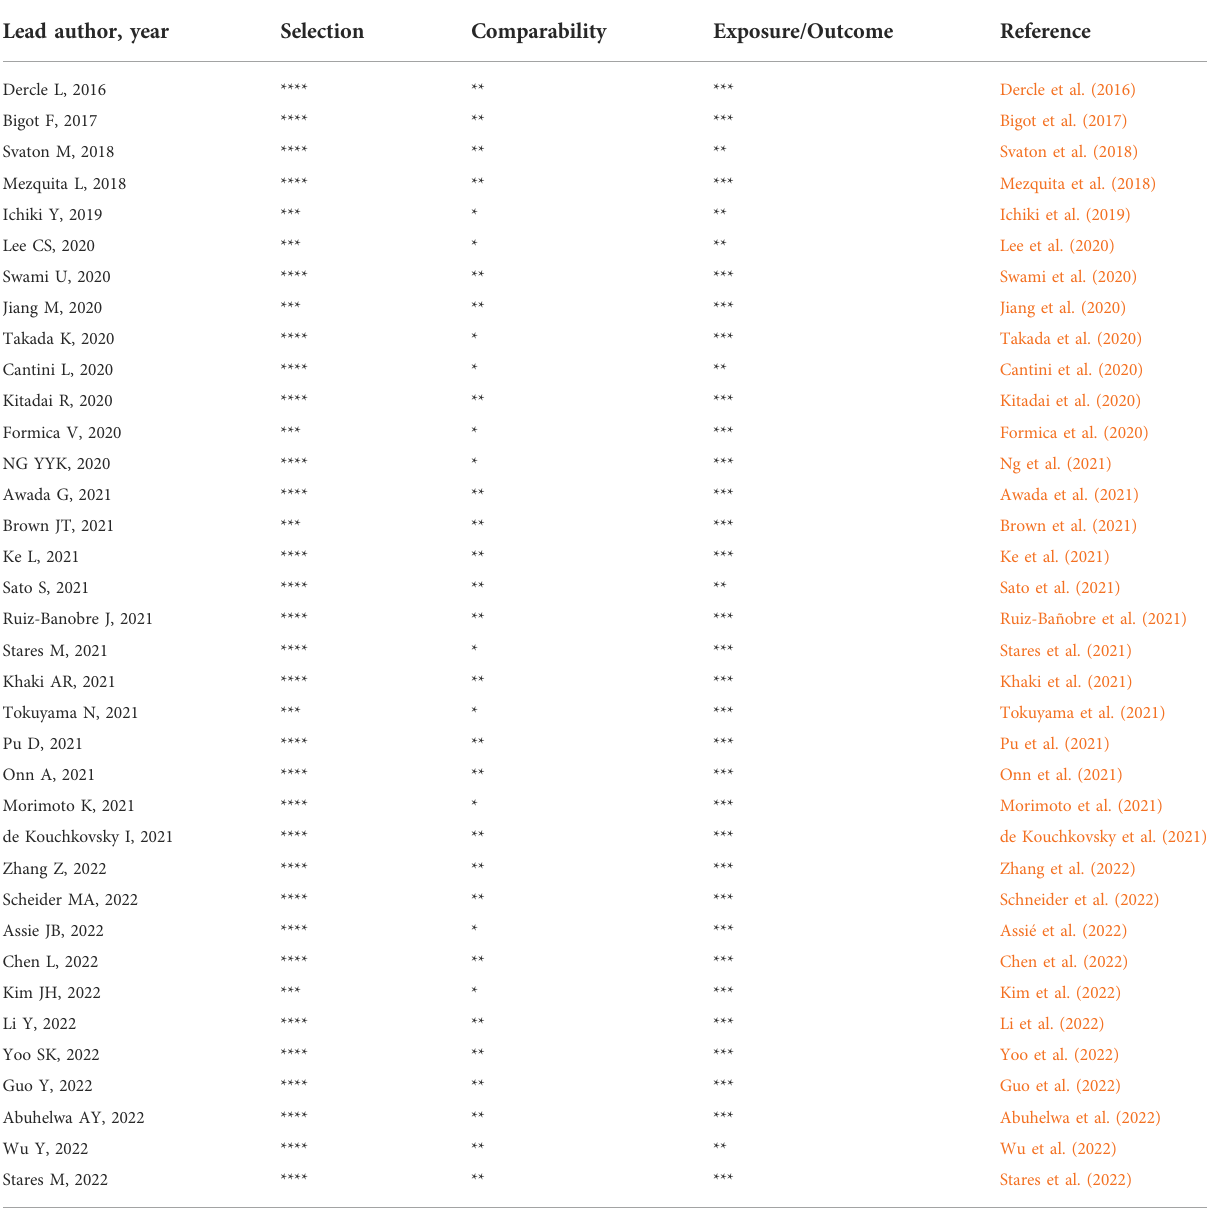
TABLE2Newcastle-Ottawascoresofincludedstudies(Note:Astarsystemwasusedforallowasemiquantitativeassessmentofstudyquality.Astudy was awarded a maximum of four stars for the selection and three stars for exposure/outcome categories. A maximum of two stars were awarded for